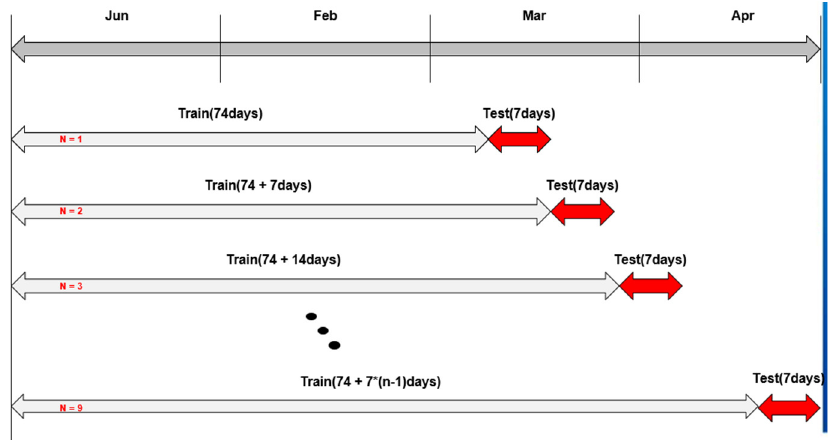
Figure 5. Verify the rules of data selection.